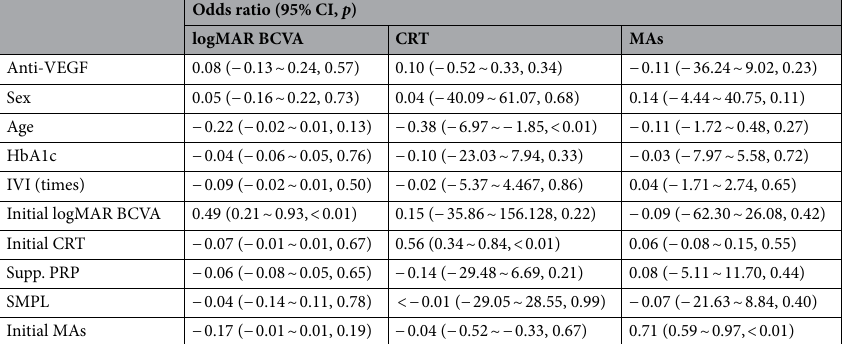
Table 3. multivariable analysis of better functional and anatomical improvements at 24 months. logMAR BCVA best-corrected visual acuity in logarithm of minimal angle of resolution, anti-VEGF anti-vascular endothelial growth factor, IVI intravitreal injection, CRT central retinal thickness, Supp. Supplementary, PRP panretinal photocoagulation, SMPL subthreshold micropulse laser, MAs